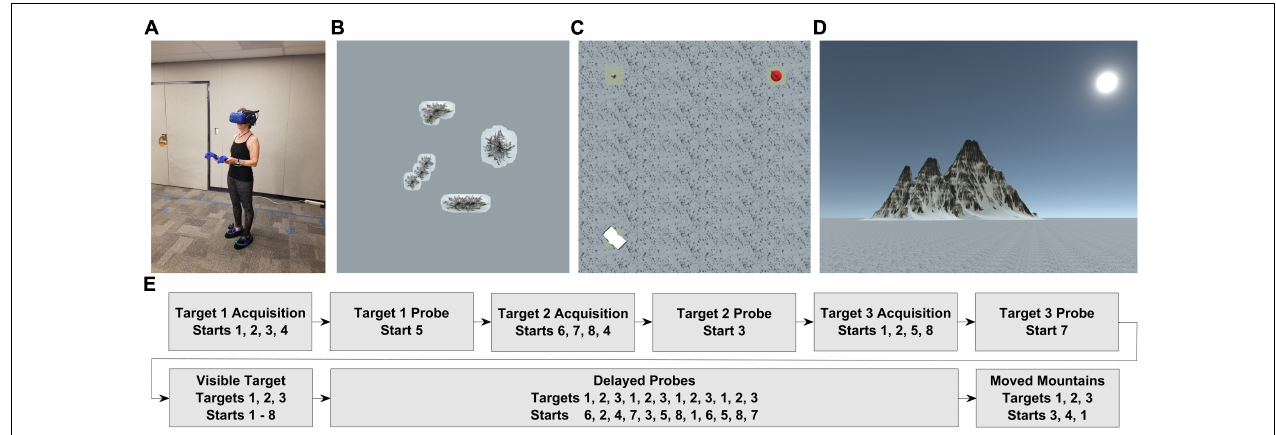
FIGURE 1 | Overview of task setup (A) . Older adult fitted with wireless HMD, battery pack, two controllers, and two foot covers with trackers (B) . Bird’s-eye-view of entire virtual environment, including the 4 distal mountains (entire environment approximately 750 × 750 m in size) (C) . Bird’s-eye-view of navigable virtual environment (approximately 5 × 5 m in size), with all three targets visible (D) . Point-of-view from the participant within the virtual environment (E) . Trial list with corresponding targets and starting locations.